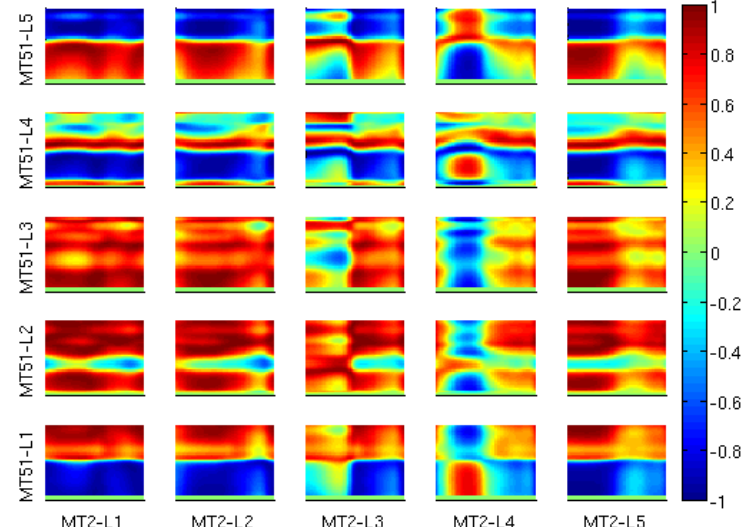
Figure 6. Correlation matrices of Legendre coefficients between the elastic scattering and the first- level-inelastic